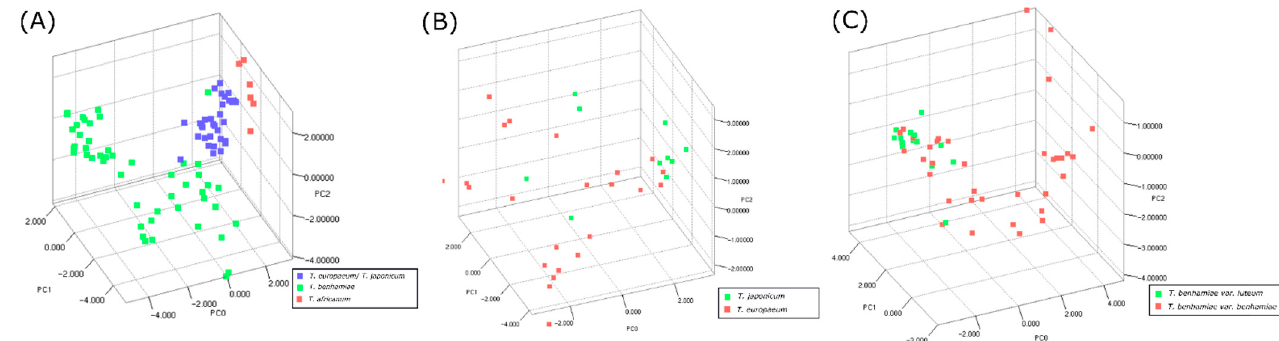
Figure 3. Principal component analysis (PCA) 3D visualization of the three first components made in MassUp. ( A ) Using the strains traditionally designated T. benhamiae ( T. africanum , T. europaeum , T. japonicum , T. benhamiae ); ( B ) using strains designated T. europaeum and T. japonicum based on ITS genotype; ( C ) using strains designated T. benhamiae var. benhamiae and T. benhamiae var. luteum based on morphology.